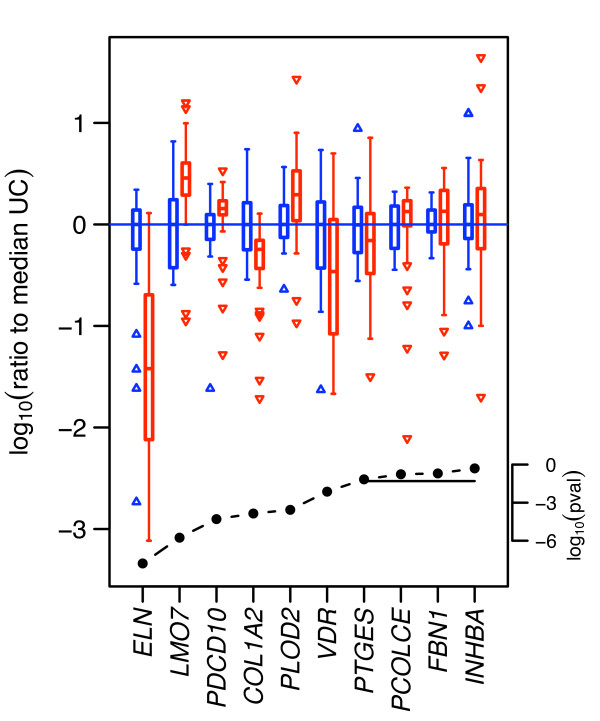
Validation by quantitative qRT-PCR. The figure presents a summary of the 10 genes selected for validation by qRT-PCR. Above each gene name are two "box-and-whisker" plots of expression levels for that gene across 32 unaffected control (UC) samples (left plot of each pair, blue, up-triangles) and 42 MFS affected samples (right, red, down-triangles). Vertical axis is log10 ratio of expression level to the median UC level. Each "box" shows the inter-quartile range (IQR), i.e., the range between the 25th and 75th percentiles of the log ratios; the horizontal line in each box is the 50th percentile (median). (Median log ratio for UC is always zero, by definition.) "Whiskers" (vertical lines) extend from each box to the most extreme values within 1.5 times the IQR from the box; in normally distributed data this would on average encompass 99% of the values. Triangles mark more extreme points. The lower curve shows log10 (p-value) for a Wilcoxon rank sum test of the null hypothesis that the UC and MFS distribution are identical; horizontal line marks the p = 0.05 significance level. 6 of 10 genes have p-values < 0.05 by this test. Most genes exhibit noticeably greater variability across the MFS samples than across UC samples, although the Wilcoxon test is not sensitive to this. To highlight one example, for Elastin (ELN), the middle 50% of the UC sample log ratios fall between -0.23 and +0.14 (i.e., the 25th and 75th percentiles of the values fall 1.70-fold below and 1.38-fold above the median, respectively), and all but 4 fall between -0.58 and +0.34 (4-fold below and 2.2-fold above median). In contrast, median Elastin level is 26 fold lower in MFS samples, only four MFS samples are above the UC median, and the null hypothesis has a p-value of 1.6 × 10-8.